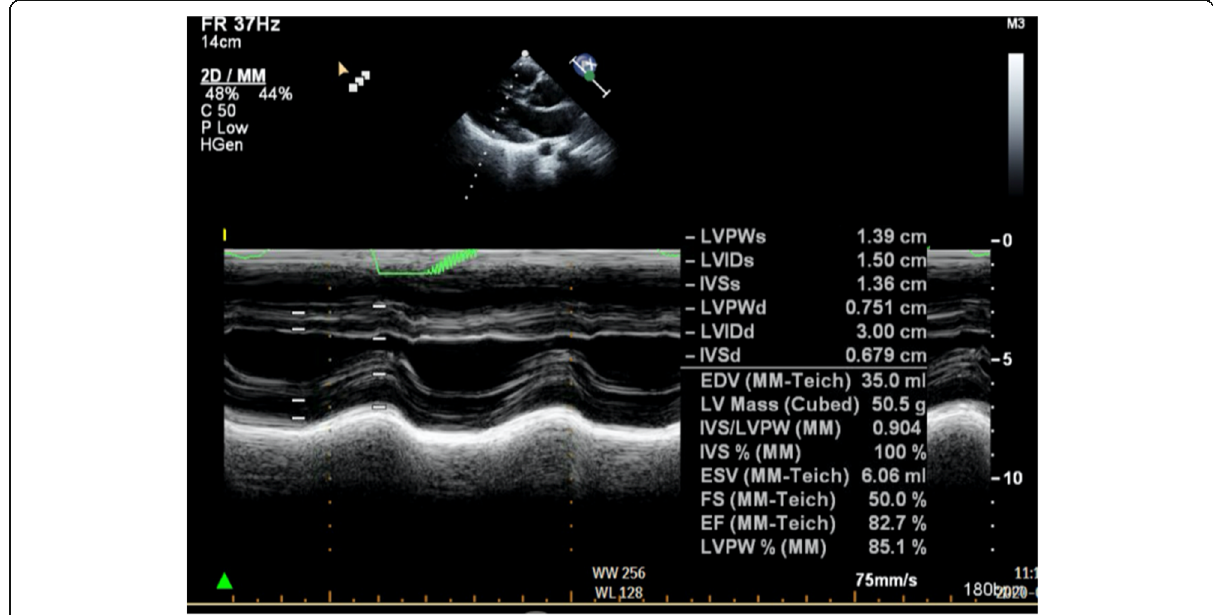
Fig. 3 Echocardiography study showed normal systolic and diastolic function with no pericardial